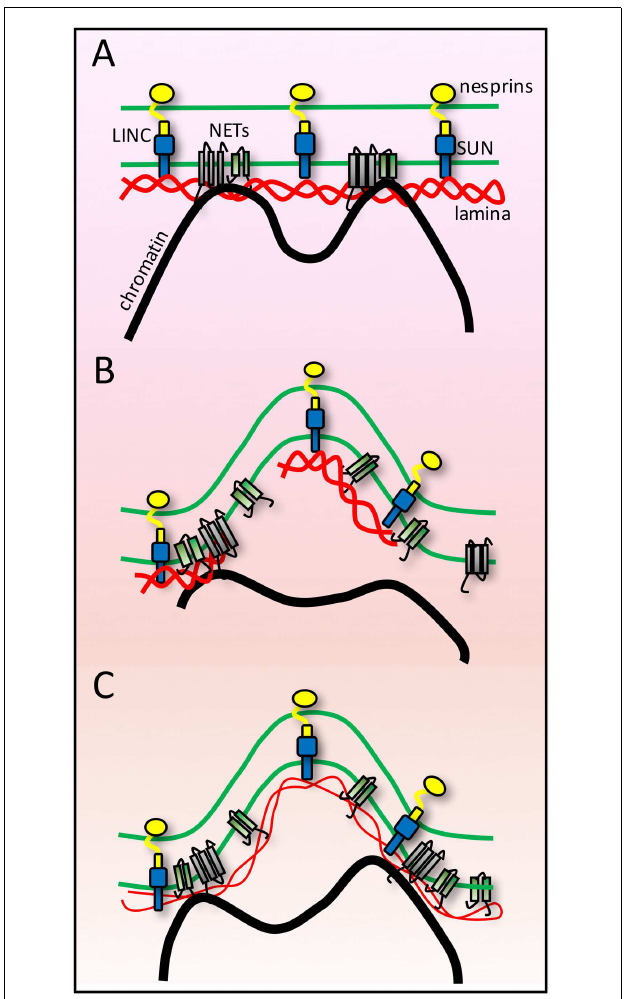
FIGURE 3 | Lamina buffering of forces from anchoring tethers. (A) High-resolution microscopy on fixed cells often shows many nuclear invaginations while live cell imaging of shows that nuclei are subject to transient deformations. As the NE endures forces from both genome and cytoskeletal interactions these findings can be interpreted as indicating the NE is at the same time extremely sturdy and extremely flexible and that individual connections must be tightly anchored for such large visible structural changes to occur in response to such forces. (B) If the lamin polymer was less strong than the forces exerted upon it, then it might break under the forces. Likewise if the polymer was strong but chromatin was not strongly anchored, then the chromatin might break away from the NE. (C) A combination of strong tethering anchors and a strong but flexible lamin polymer would allow the nuclear structural changes observed.